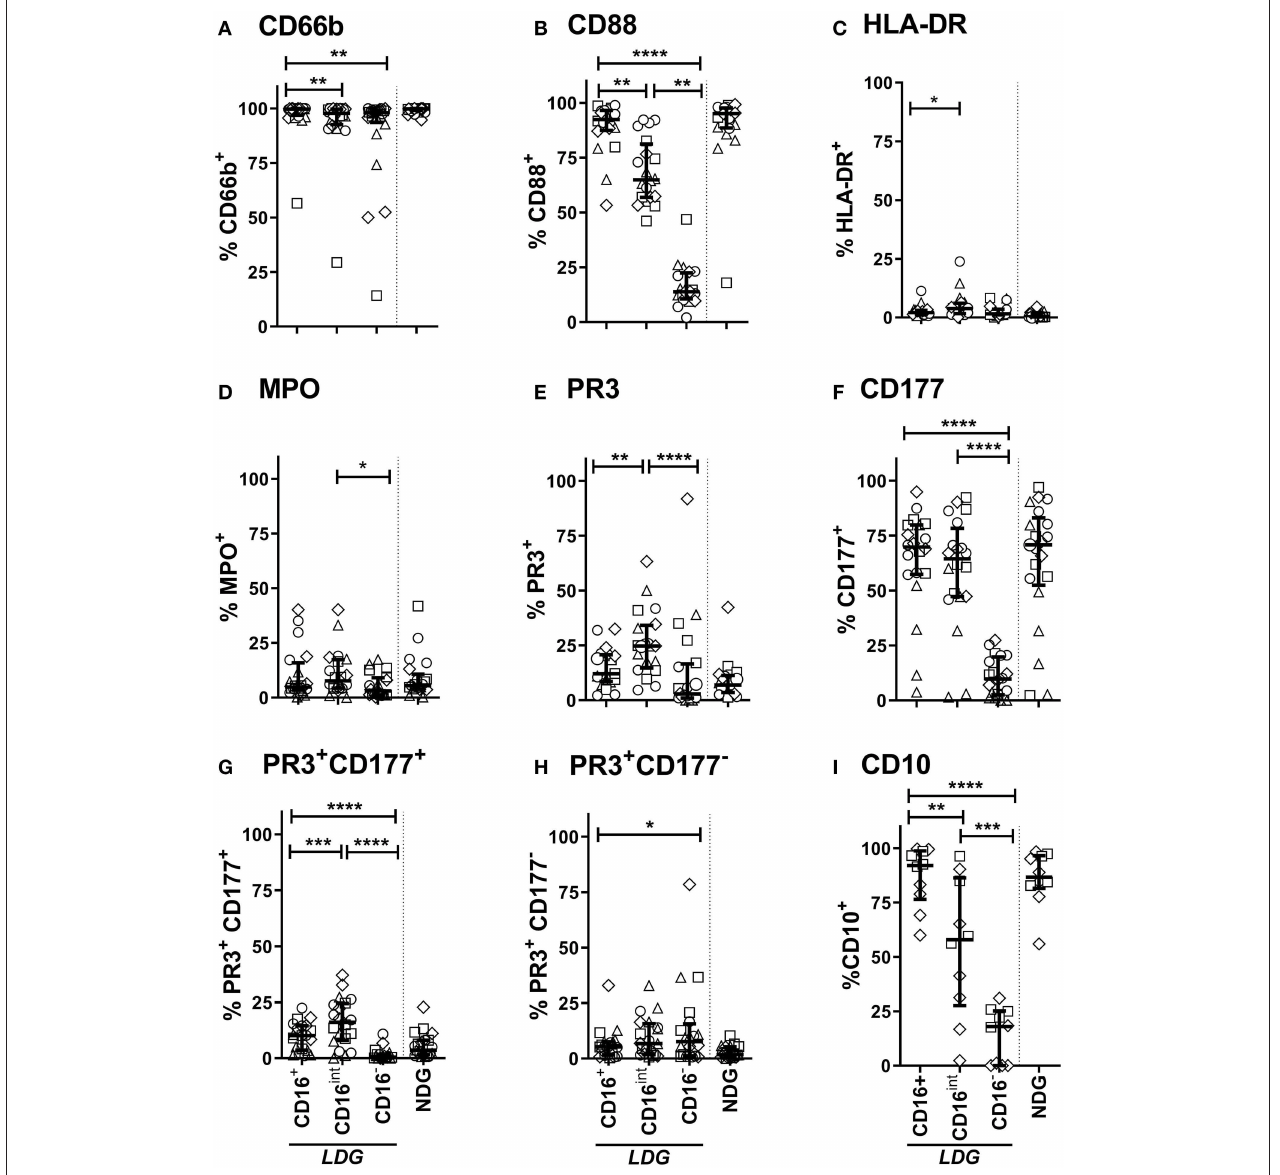
FIGURE 3 | LDG Surface immune markers vary according to CD16 expression. Surface expression of CD66b (A), CD88 (C5Ar) (B), HLA-DR (C), MPO (D), PR3 (E), CD177 (F), PR3 CD177 co-expression (G), PR3 independent of CD177 (H), and CD10 (I) on CD16 + , CD16 int and CD16 − LDG subsets are represented. Equivalent surface expression on NDG is represented beyond the dotted line for visual comparison. Data are from Age-matched healthy control ( △ n = 5), Disease control ( 2 n = 5), Remission AAV ( ◦ n = 6), and Acute AAV ( ⋄ n = 4) and presented as median with IQR. Differences between LDG subsets were analyzed using Friedman’s paired test, with post hoc comparison of groups using Dunn’s test. * p < 0.05, ** p < 0.01, *** p < 0.001, **** p <